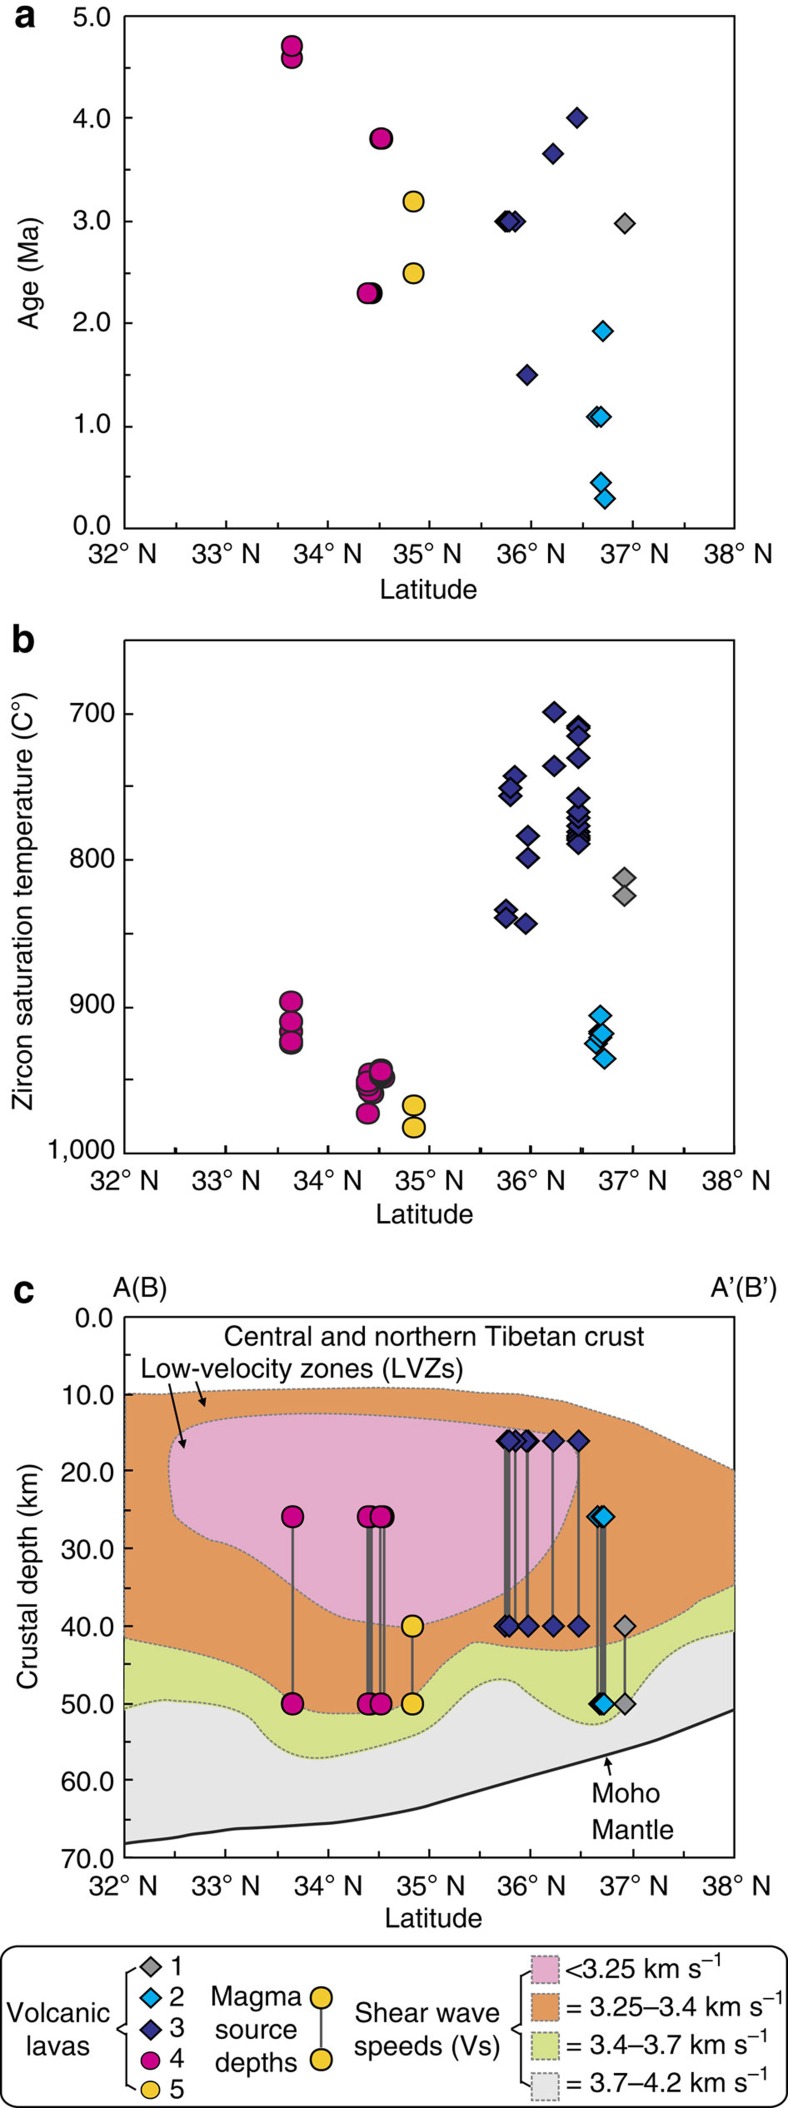
Variations in selected magma characteristics with latitude.(a) Plot of ages of volcanic lavas against latitude. The age data for the Pliocene-Quaternary felsic volcanic lavas of the central and northern Tibetan Plateau are from Supplementary Data set 1). (b) Plot of zircon saturation temperatures against latitude using the approach of Watson and Harrison45 (data summarized in Supplementary Data set 1. (c) The estimated depths of the magma sources plotted against latitude. The estimated crustal depths are summarized in Supplementary Data set 1. The sketched range for the low-velocity zones (LVZs) in the Tibetan crust is based on the geophysical data across the central and northern Tibetan Plateau (refs 1, 8, 14, 15, 17, 20, 21, 22), and the vertical cross-sections of shear wave speeds in absolute units (Vs) along the A–A′ and B–B′ profiles (Fig. 1a) are from Yang et al.22 and Hacker et al.17. The symbols are as follows: 1, Pliocene (2.97 Myr ago) adakitic trachyandesites in the Zhaixinshan area of the Central Kunlun Block; 2, Quaternary (1.08–0.3 Myr ago) non-adakitic trachyandesites in the Jindingshan area of the Central Kunlun Block; 3, Pliocene-Quaternary (4.0–1.5 Myr ago) rhyolites in the Songpan-Ganzi Block; 4, Pliocene-Quaternary (4.7–2.3 Myr ago) non-adakitic felsic volcanic lavas in the central-northern Qiangtang Block; 5, Pliocene (3.2–2.5 Myr ago) adakitic rhyolites in the Henglianghu area of the central-northern Qiangtang Block.